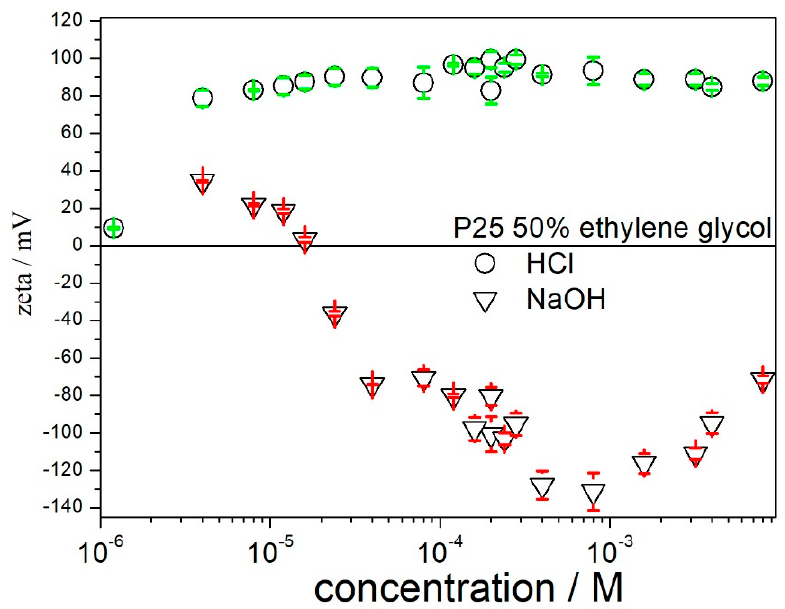
Figure 2. The effect of acid and base on the zeta potential of titania in 50% EG.